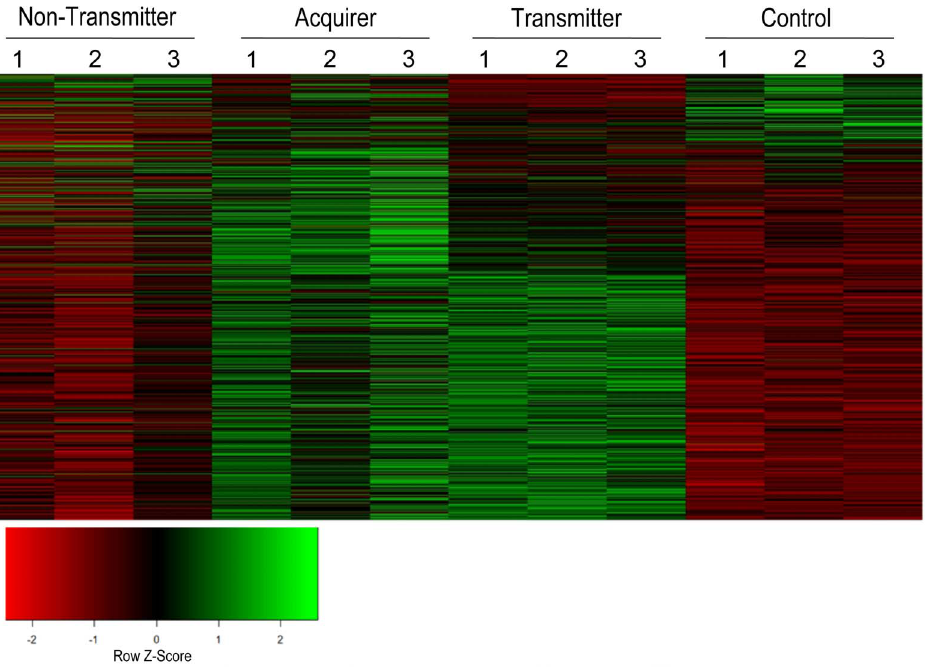
Figure 1. Heat map for expression of 891 differentially expressed G. nigrifrons transcripts. Differentially expressed transcripts were identified using one-way ANOVA ( P , 0.05; RPKM change . 2). Each row represents an individual transcript; each column labeled 1–3 represent replicate samples of non- acquirers, acquirers, transmitters, or the healthy control, as outlined in the Methods. For each transcript (row), the relative expression level for each sample is represented by a color that reflects its z-score (shown in the redgreen key), calculated by subtracting the mean expression value for the row from the sample value and dividing by the standard deviation for the row.